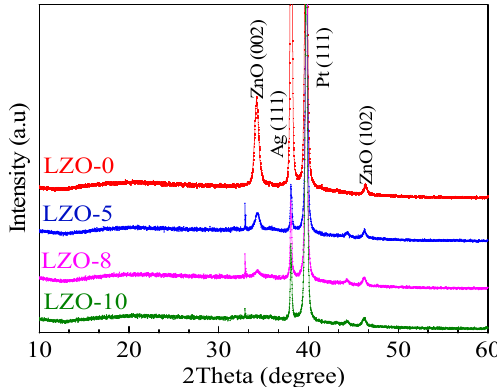
Figure 4. The X-ray diffraction (XRD) spectrum of LZO-0, and LZO-5, LZO-8, and LZO-10 devices.